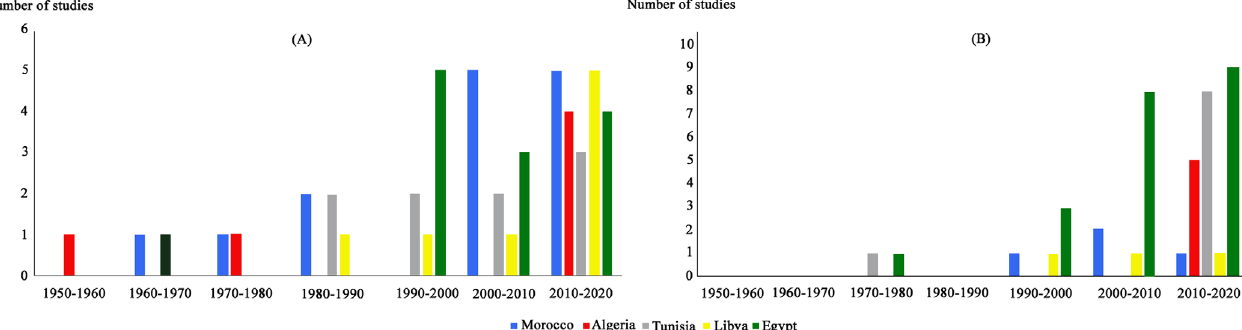
Figure 10. Distribution of studies dealing with human and animal toxoplasmosis in fi ve North African countries over time (Morocco, Algeria, Tunisia, Libya and